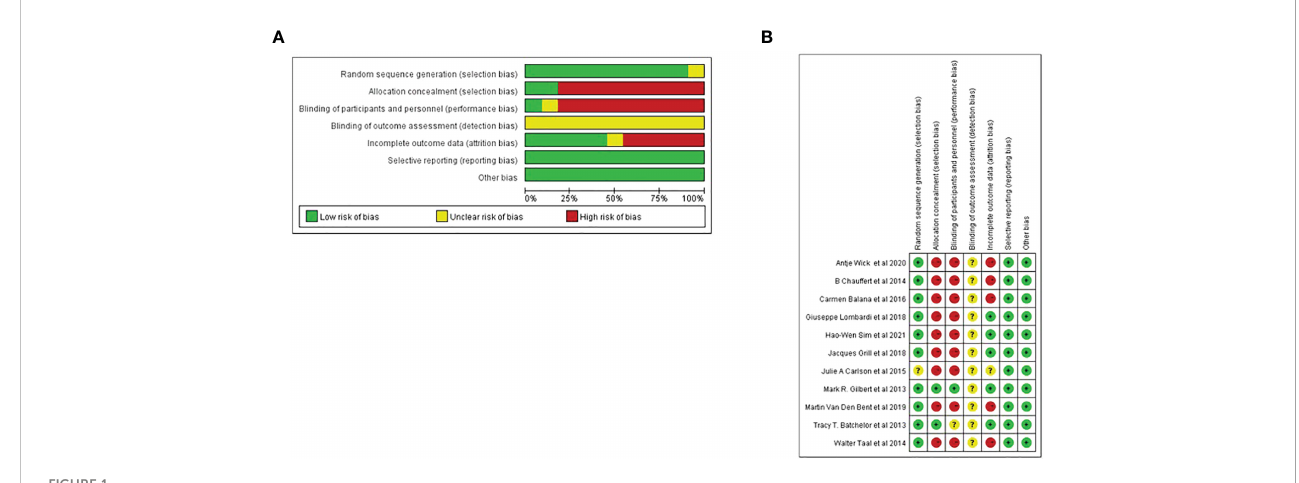
FIGURE 1 Risk of bias. (A) Risk of bias graph. (B) Risk of bias